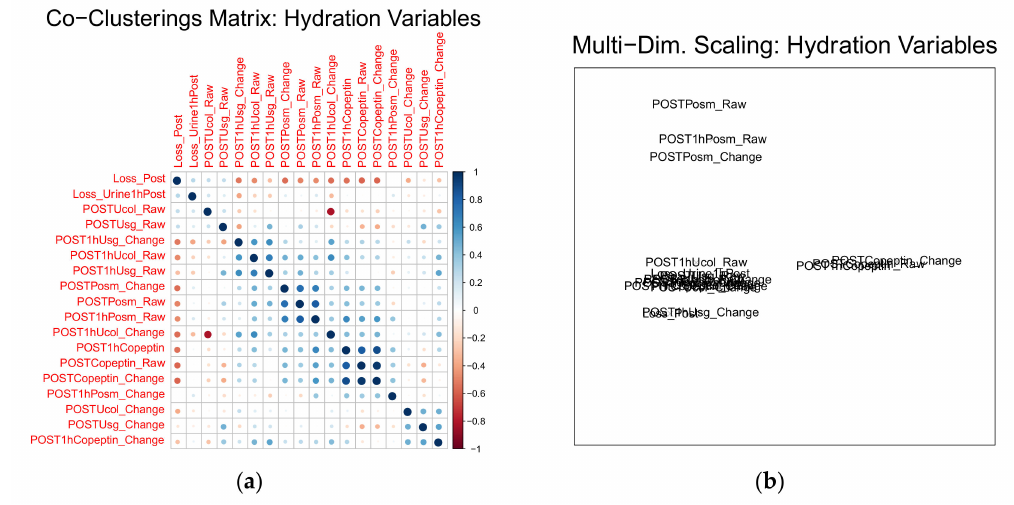
Figure 4. Graphical depictions of associations among 18 hydration biomarkers. Correlation heat-map ( a ); multi-dimensional scaling view ( b ); multi-dimensional scaling view created by raising correlation matrix to the fifth